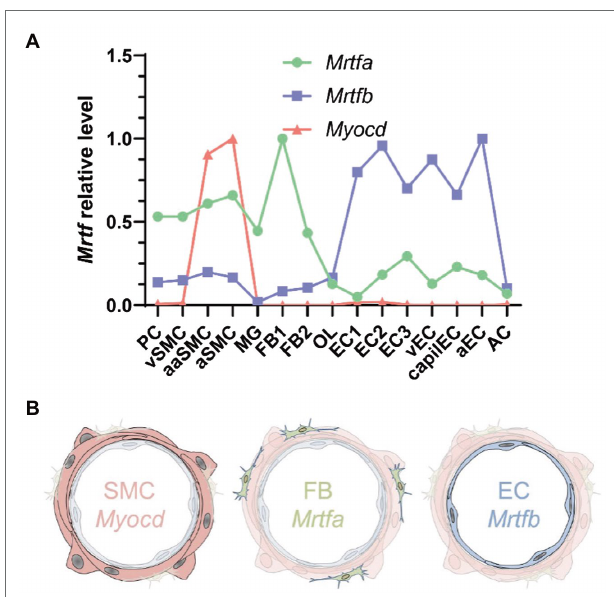
FIGURE 7 | MRTF distribution across the vascular wall. (A) Shows cell- averaged mRNA expression data for the indicated transcripts in different cerebrovascular cell types. PC, pericytes; SMC, smooth muscle cells; MG, microglia; OL, oligodendrocytes; FB, fibroblasts; EC, endothelial cells; AC, astrocytes; v, venous; cap, capillary; a, arterial; aa, arteriolar; and 1, 2, and 3, subtype. (B) Shows a schematic representation of Myocd in SMCs, Mrtfa in FBs, and Mrtfb in